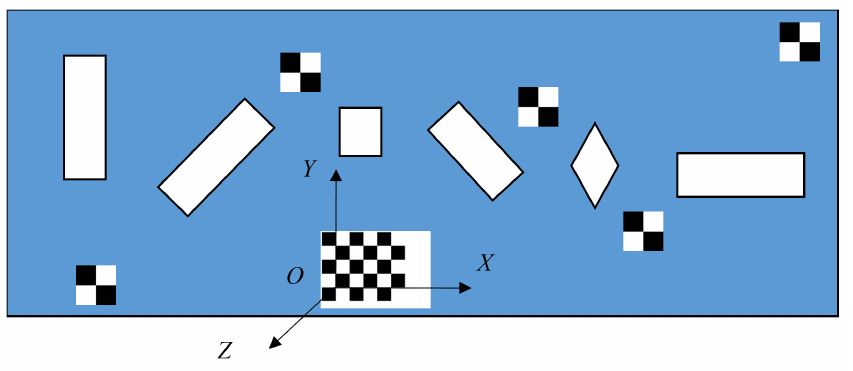
Figure 9. Simulated imaging